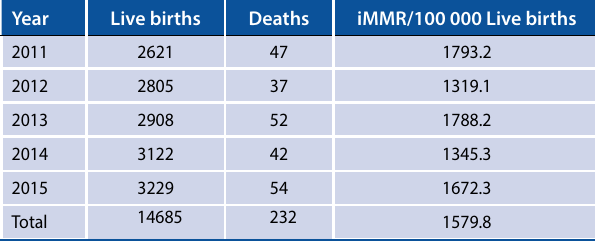
Figure 1: Age distribution of the patients. Table 1: Trends in the MMR (2011–2015)